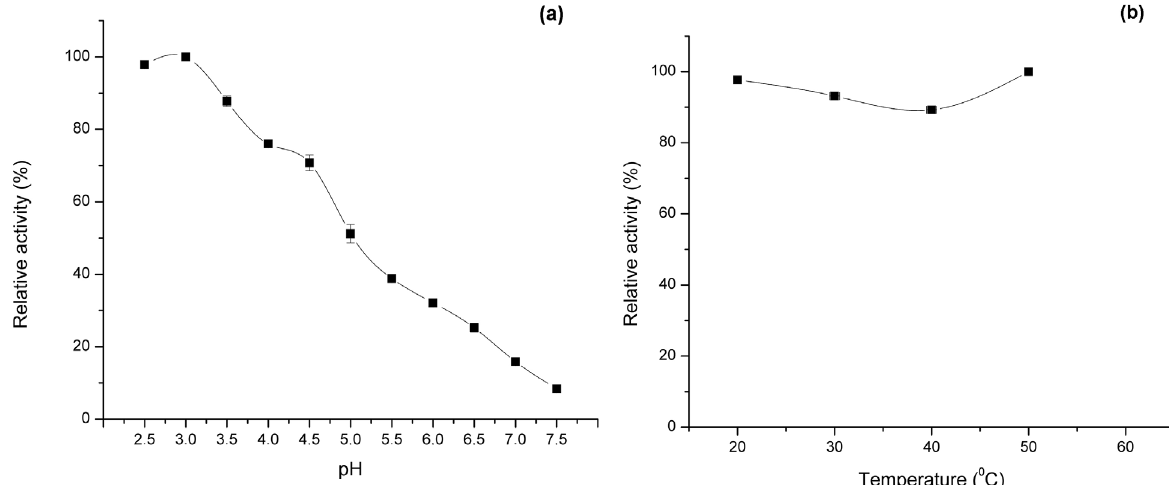
Figure 4. Stability of the P. sajor-caju laccase at (a) different pH values and (b) different